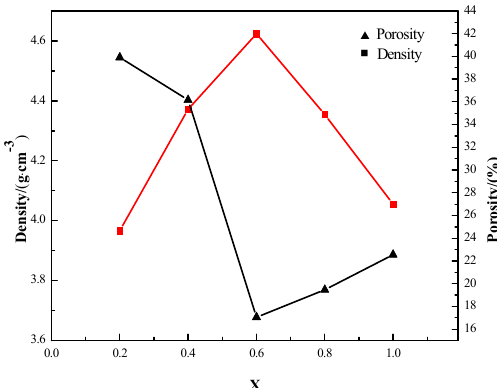
Figure 5. Density and porosity of AlCrFeNiSi x high-entropy alloy.